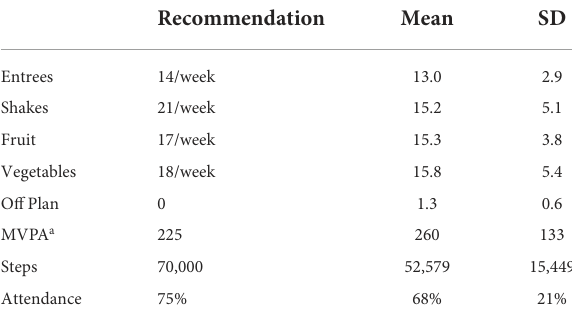
TABLE 5 Program recommendations, diet and physical activity adherence and weekly self-monitoring ( n =